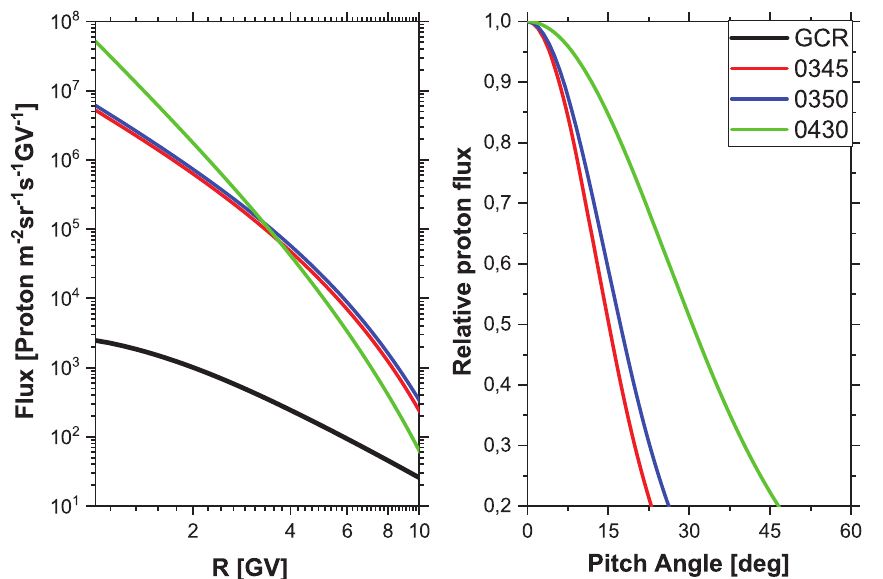
Fig. 3. Derived rigidity spectra and PAD during GLE #5 at various stages of the events speci fi ed in UT time in the legend. Left panel corresponds to the derived rigidity spectra, while the right panel corresponds to the corresponding pitch angle